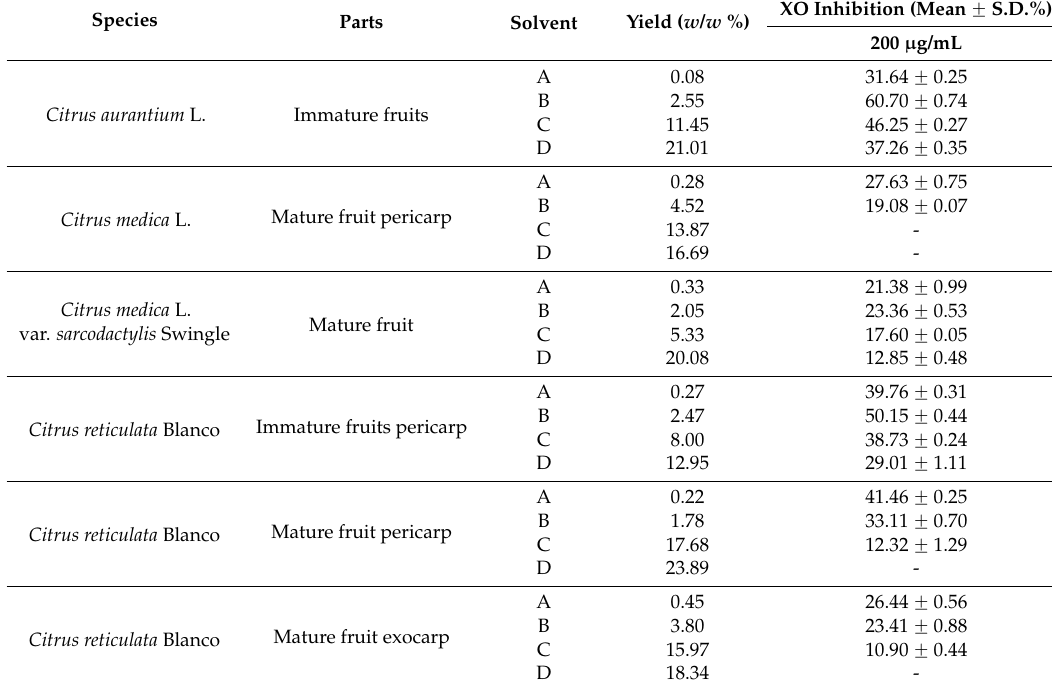
Table 1. Yield and XO inhibitory effects of the prepared